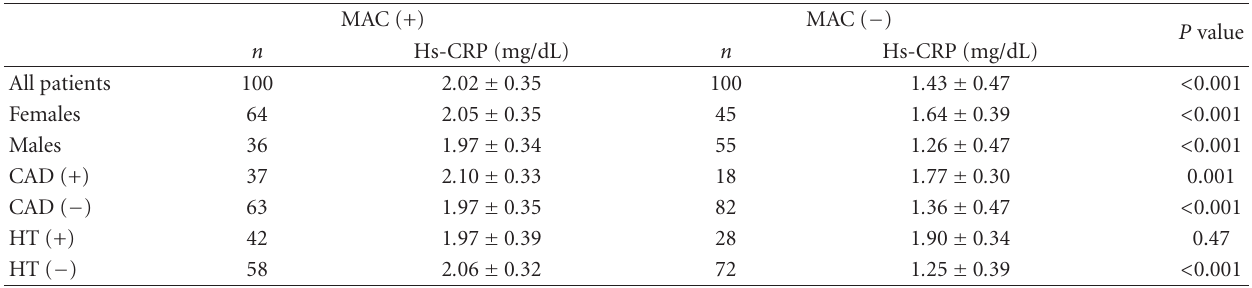
Table 3: Hs-CRP levels in the MAC and control group.